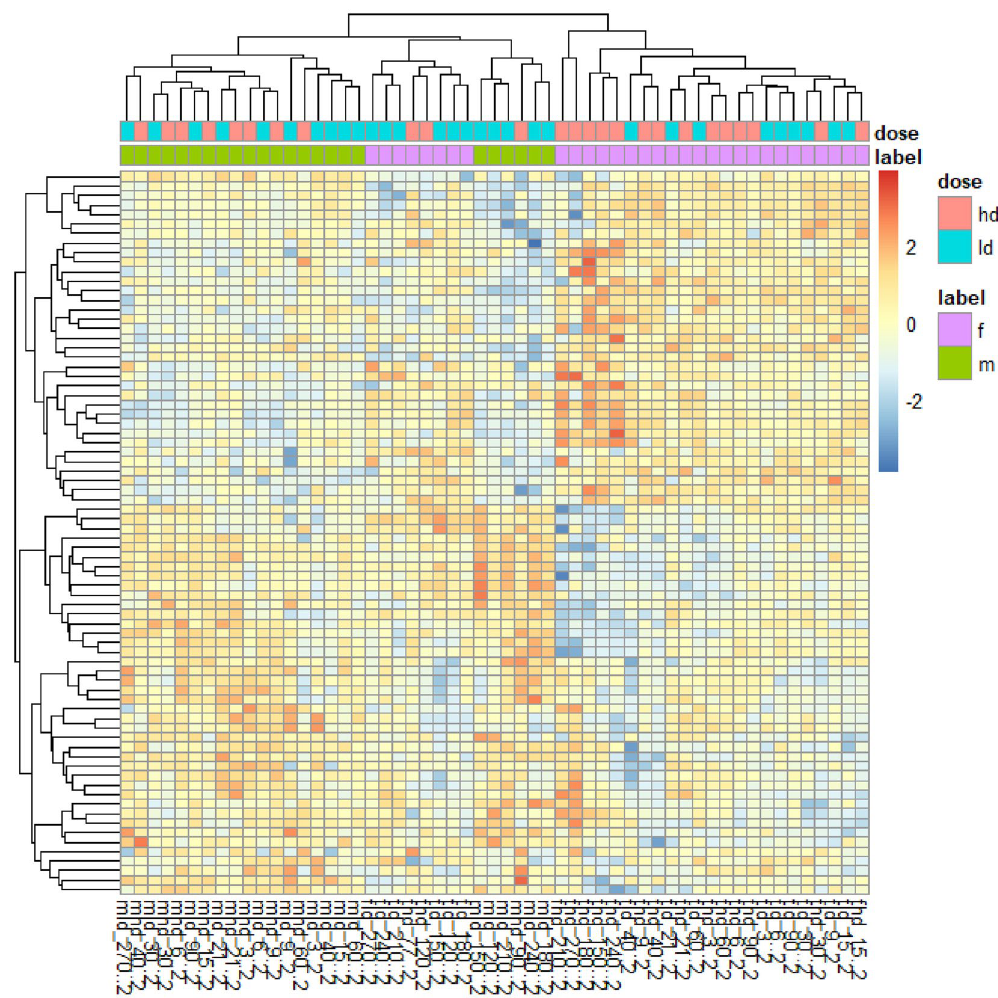
Figure 3. Two-way top-level ANOVA revealed the 76 miRNAs that are expressed by both doses and both genders at any time point (p ≤ 0.05). Although these miRNAs are common between males and females at any timepoint, the expression pattern by time segregates well by